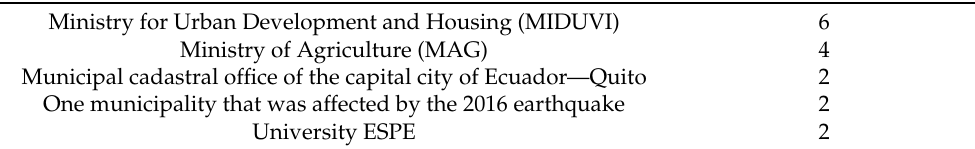
Table 2. An overview of consulted number of experts during the